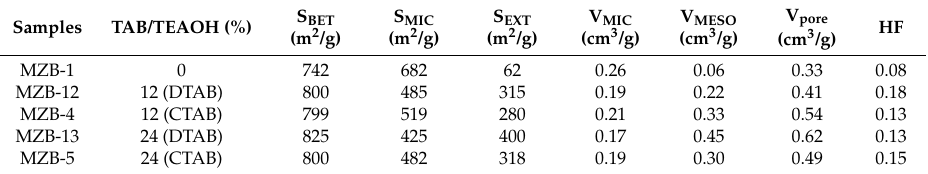
Table 5. Pore structure parameters of hierarchical Beta zeolites with different TAB. Samples